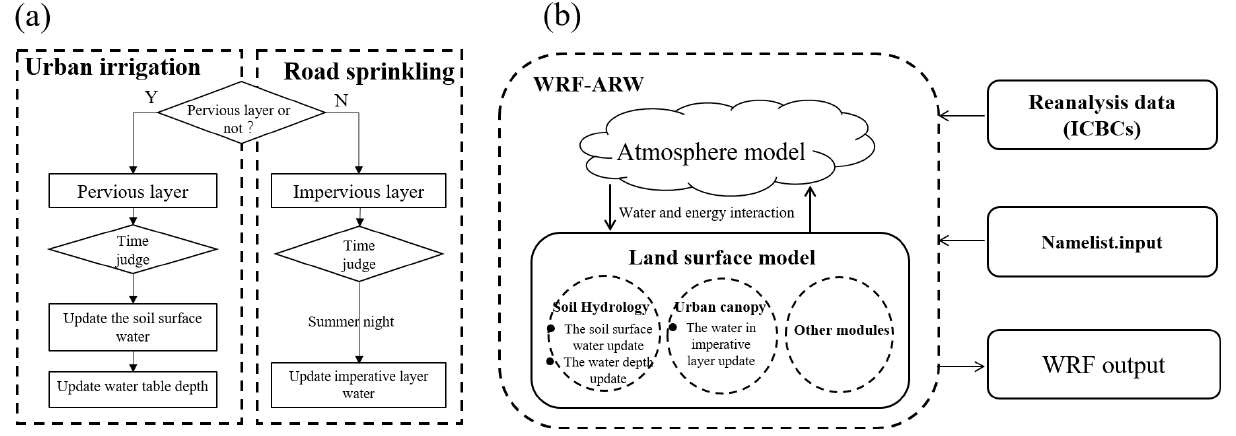
Figure 1. Water usage scheme and its coupling with the Weather Research and Forecasting (WRF) model. (a) Flowchart illustrating the water usage scheme, including urban irrigation and road sprinkling. (b) Schematic showing the WRF model coupled with the water usage scheme. Table 1. Data set